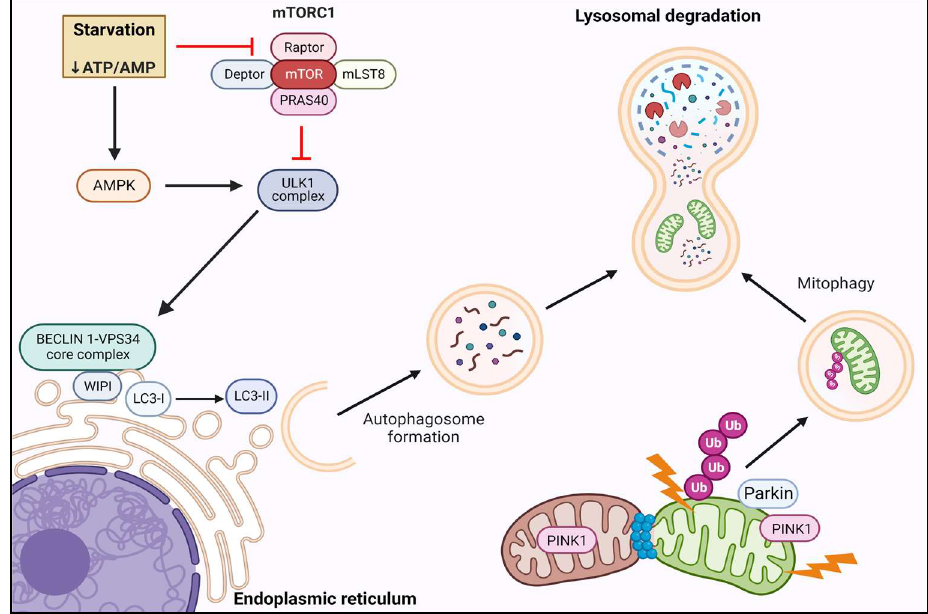
Figure 3. Autophagy and mitophagy pathways. Autophagy induction is negatively regulated by mTORC1 signaling through direct inhibition of ULK1 activity. During periods of nutrient deprivation, mTORC1 activity is blunted, thereby releasing inhibition of the ULK1 initiation complex. Additionally, activation of AMPK under conditions of energetic stress directly facilitates ULK1 activation. Recruitment of the Beclin-VPS34 core complex to the ER facilitates LC3 lipidation and autophagosome membrane expansion. Loss of mitochondrial Δψm triggers OMM PINK1 accumulation and Parkin recruitment, which results in polyubiquitination and sequestration of damaged mitochondria in autophagosomes for lysosomal degradation.